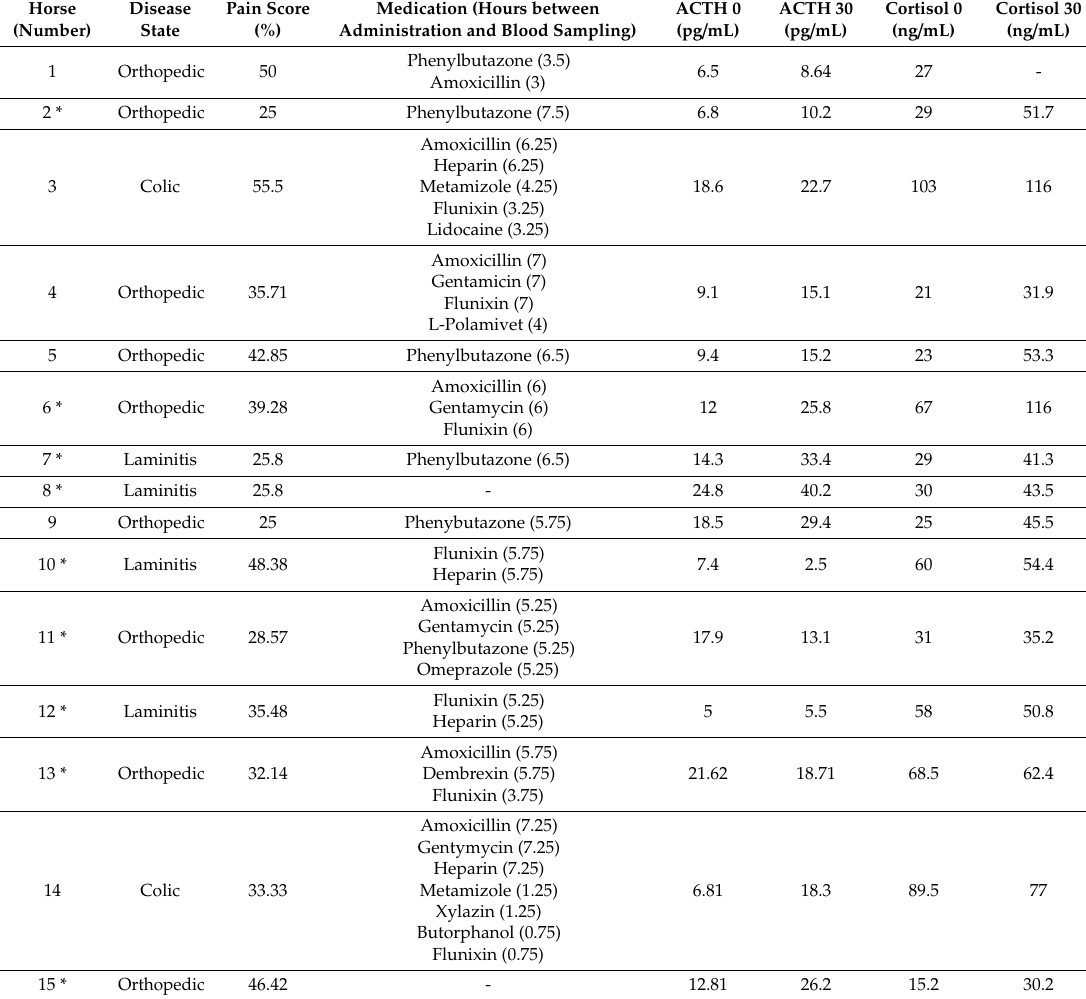
Table 6. TRH stimulation test of horses treated for painful